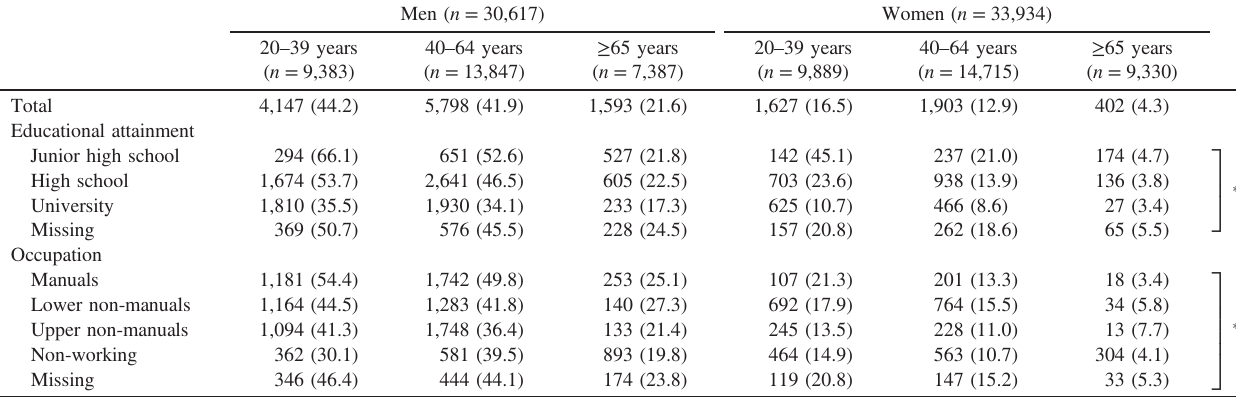
Table 2. Number (and prevalence) of current smoking according to age, gender, education, and occupation Men ( n = 30,617)